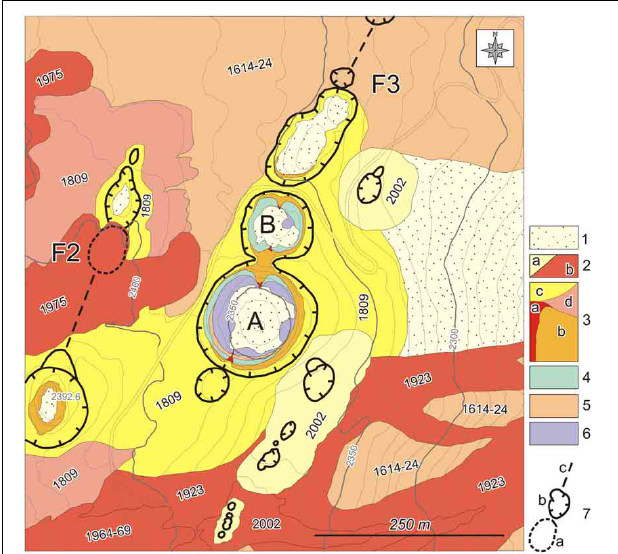
FIGURE 2 | Geological map of the central portion of the 1809 volcanics and structures, between 2440 and 2260m asl. The 1809 lavas and pyroclasts are partially buried by younger volcanics. (A,B) are the main craters described in the text. Unit 1. talus deposit; Unit 2. post–1960 lavas (a) and cinder cones (b), dates indicate the age of the eruption; Unit 3. Volcanic products of the 1809 eruption, analyzed in the present paper: dykes (a), cinder cones (b), lithic material erupted by phreatomagmatic (Surtseyan) activity (c), lava flows (d); Unit 4. cinder cone of unknown age (between 1624 and 1809); Unit 5. 1614–1624 lava flows; Unit 6. Volcanics belonging to the Ellittico volcanic center ( ∼ 15 ka). 7. Eruptive fissures: buried craters (a), outcropping craters (b), dry and/or buried fractures (c). Note the en–echelon arrangement of the lower portion of fissure F2 (left) and the higher portion of fissure F3 (right), as indicated in Figure 1